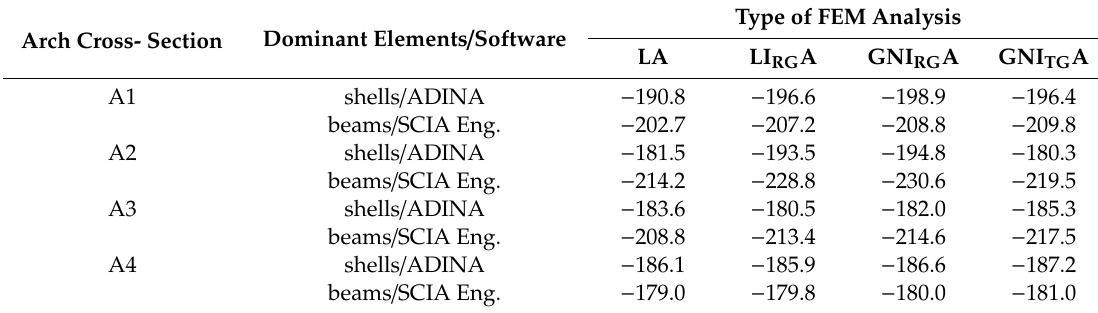
Figure 9. Side view of the bridge with the designation of the four selected arch cross-sections, where the stresses were analysed (dimensions in millimetres).